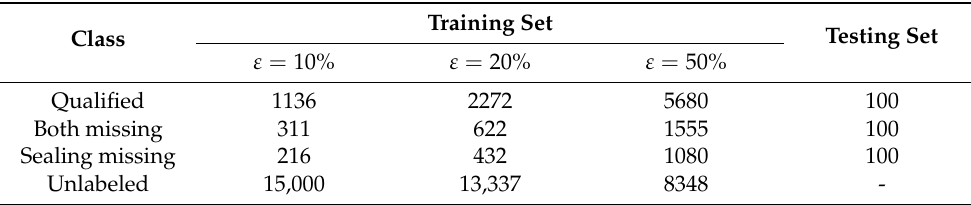
Table 1. Image numbers of the classes in training set and testing set